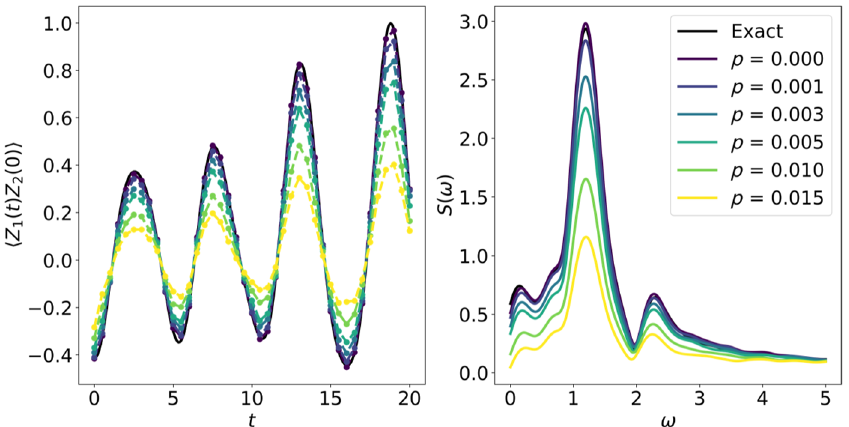
FIG. 8. Noisy emulation of the [4Fe- 4S] model